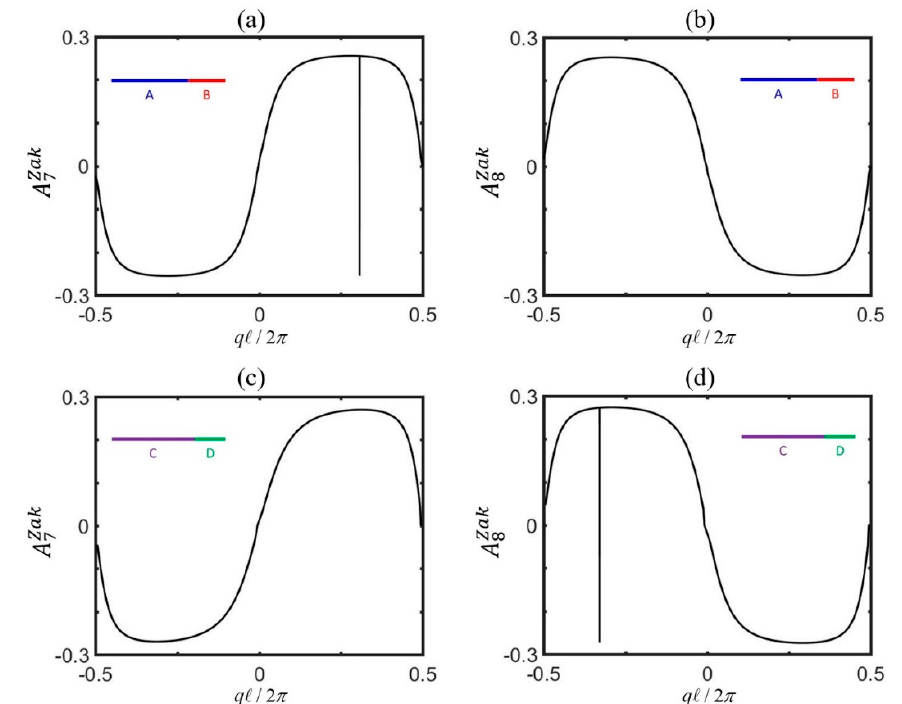
Figure 4. The evolution of Zak connections for the 7th and 8th bands of the ES-I and the ES-II. ( a ) and ( b ) are the results of the 7th and 8th band of ES-I. A singularity of Zak connection appears in ( a ) within Brillouin zone. ( c , d ) are the results for the 7th and 8th band of ES-II. After the band inversion, the Zak connection evolution shows that the singularity in 7th band ( a ) band has switched to the 8th band ( d ). Due to the gauge transformation, the two position of the singularities in ( a , d ) are symmetric.